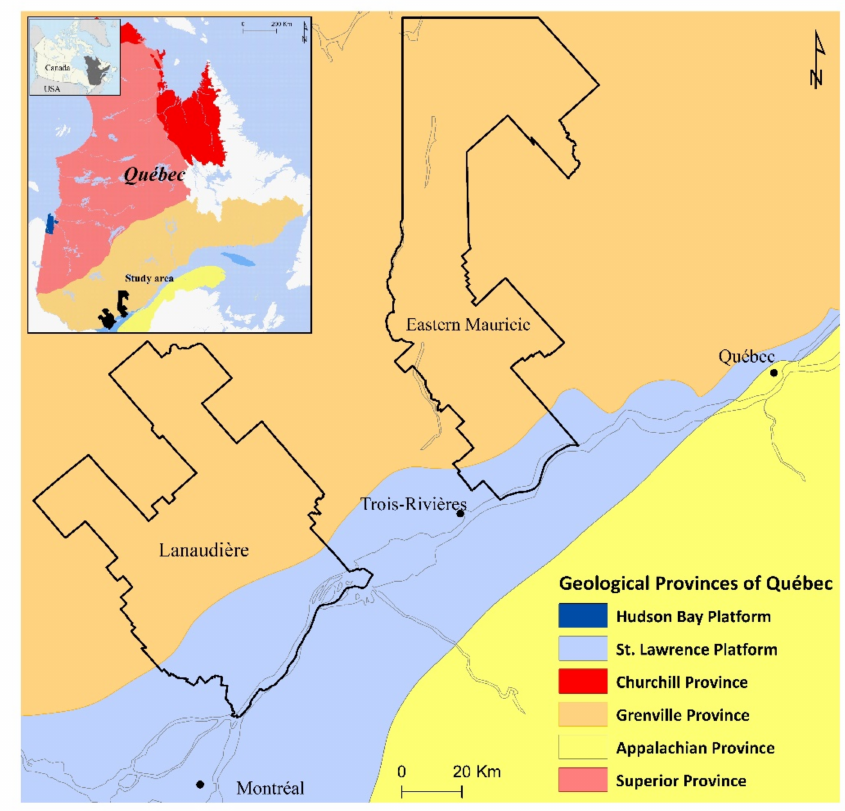
Figure 1. Geological provinces within Quebec (inset) and the location of the study areas of the Lanaudi è re and Eastern Mauricie administrative